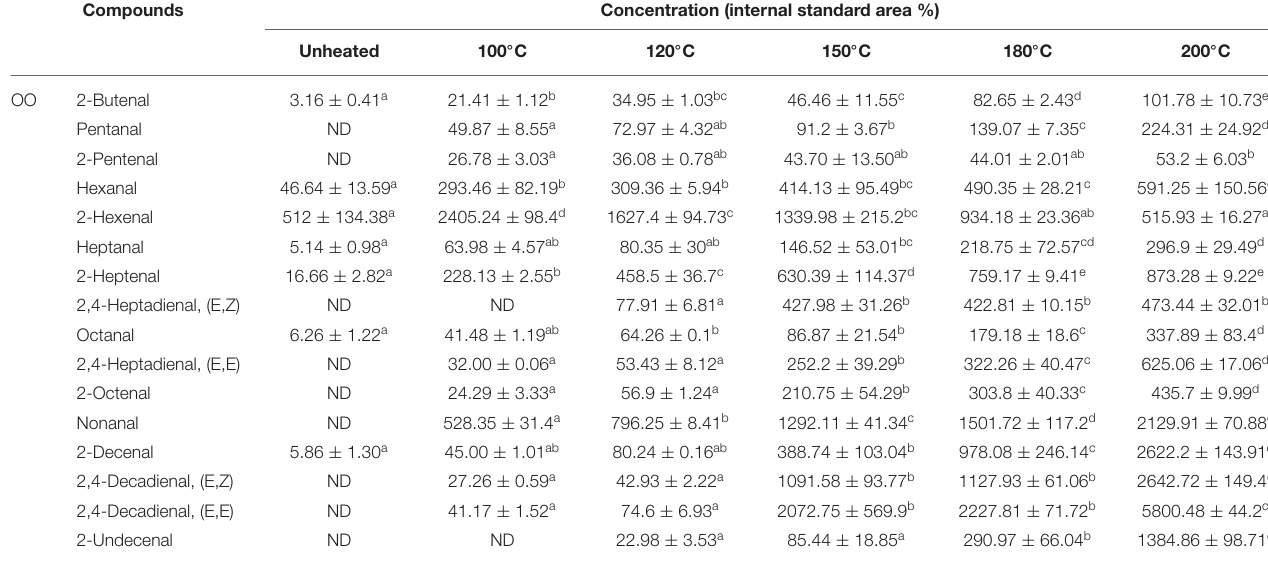
TABLE 3 | Changes in the volatile oxidation products of OO at different heating temperatures. Compounds